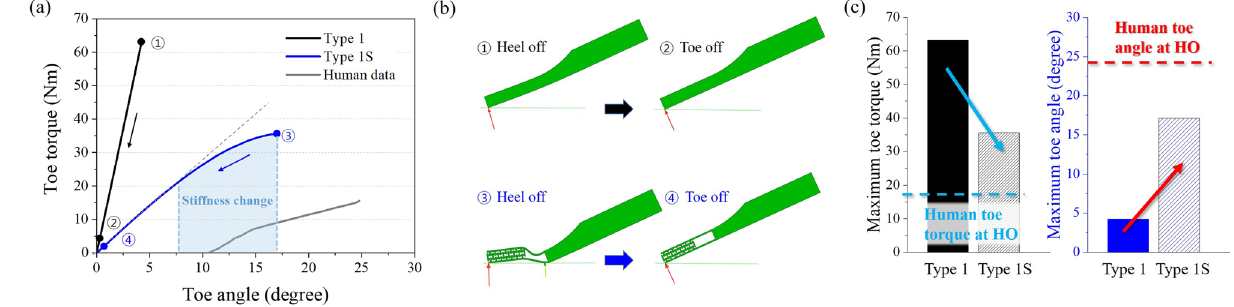
Figure 5. Simulation result of Type 1 and Type 1S models and reference human data 18 from heel off to toe